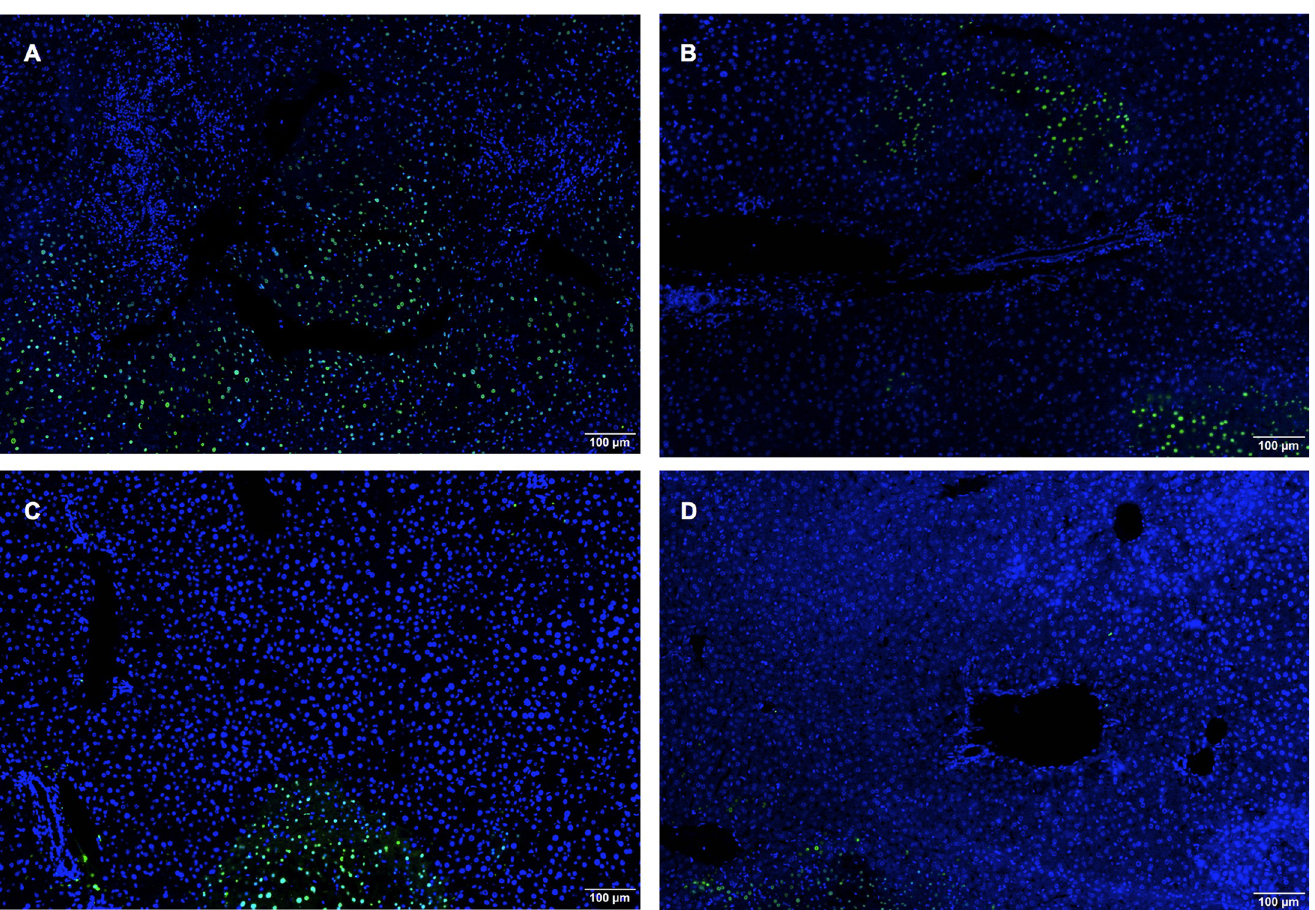
Fig 3. Representative sections of liver parenchyma, stained with TUNEL. (A) Representative section of tissue from a liver in the vehicle group. (B) Representative section of tissue from a liver in the F573 group. (C) Representative tissue from a liver in the anakinra and etanercept group. (D) Sample liver tissue from the BMX-001 group. Tissue was stained using fluorescein-12-dUTP